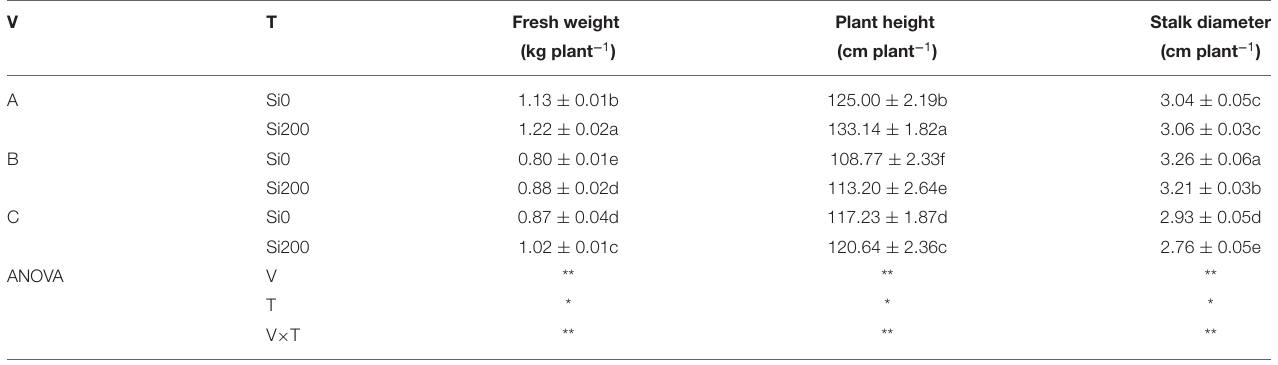
TABLE 1 | Growth parameters of the three sugarcane varieties under the two silicon (Si) treatments.